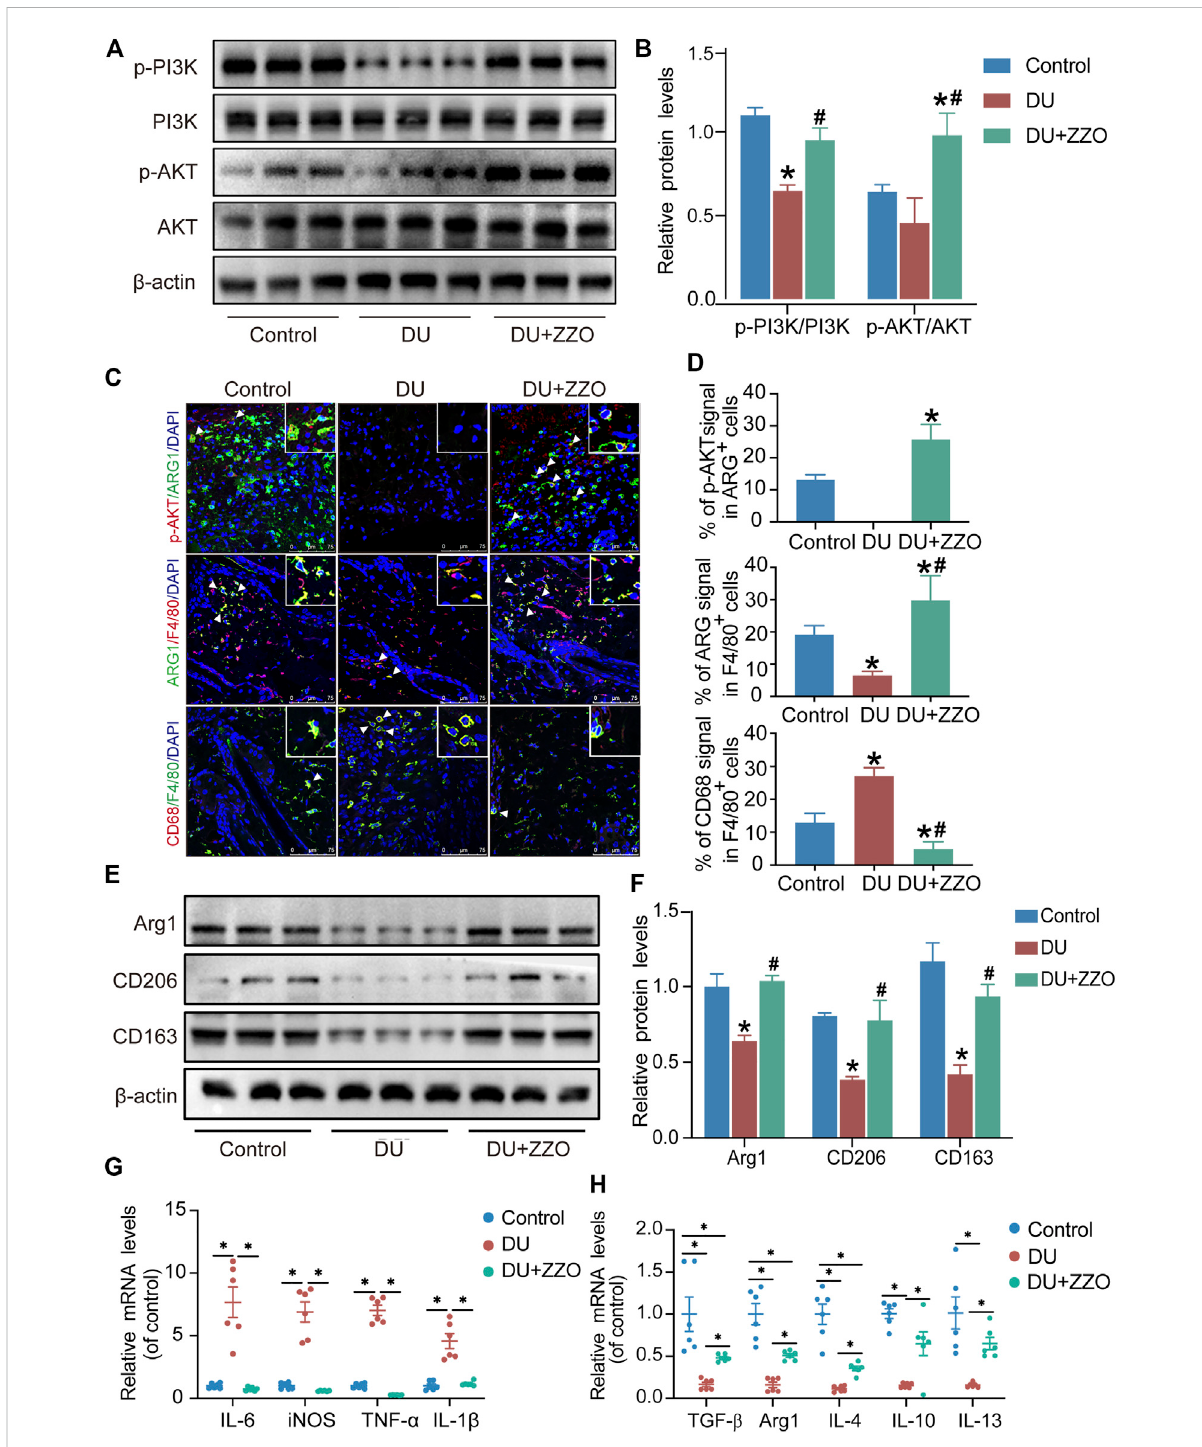
FIGURE 8 ZZO suppressed M1 macrophage-induced in fl ammation by activating the PI3K-AKT signaling pathway. (A,B) Expressions of PI3K, p -PI3K, AKT, and p -AKT proteins weretested inwound tissues ( n = 3, * p < 0.05, compared with thecontrol group, # p < 0.05, comparedwith the DU group). (C,D) Co-localization of p -AKT/ARG1, ARG1/F480, and CD68/F480 ( n = 3, * p < 0.05, compared with the control group, # p < 0.05, compared with the DU group,Scalebar=75 μ m). (E,F) ExpressionsofARG1,CD206,andCD163proteinsweretestedinwoundtissues( n =3,* p < 0.05,comparedwith thecontrolgroup, # p < 0.05,comparedwiththeDUgroup). (G) mRNAexpressionofM1macrophagemarkers( n =6,* p < 0.05). (H) mRNAexpression of M2 macrophage markers ( n = 6, * p <